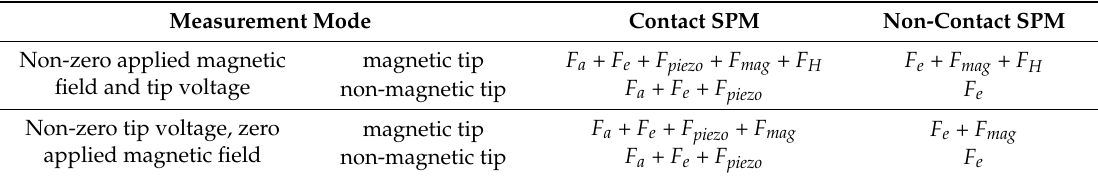
Table 1. Forces involved in the measurement of a multiferroic sample in different